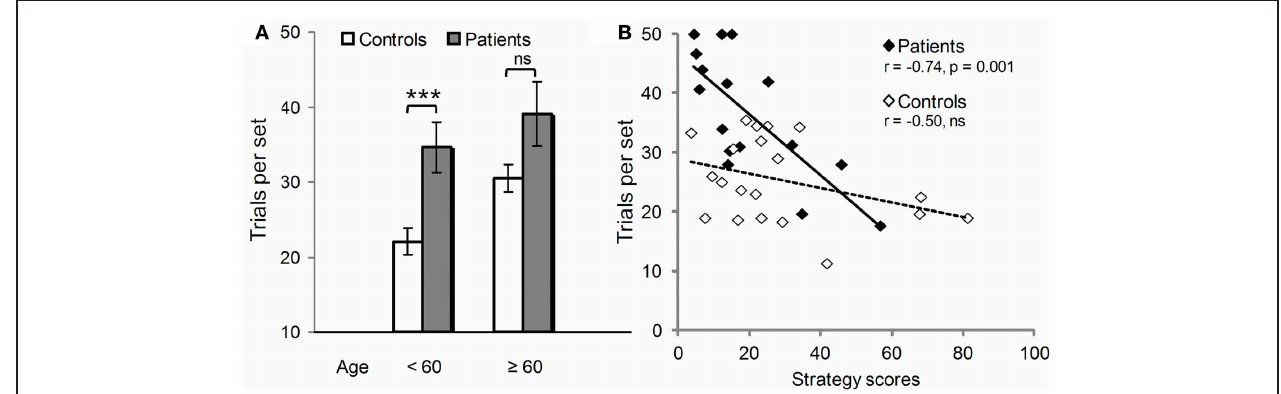
than that of normal aging (two-sample t -tests: n.s., non significant p = 0 . 10). (B) Irrespective of age, PD effect on learning (y axis, trials per set) varied across individuals depending on their ability to use the optimal learning strategy (strategy scores, x-axis) as revealed by Pearson correlation analyses ( r ’s and p